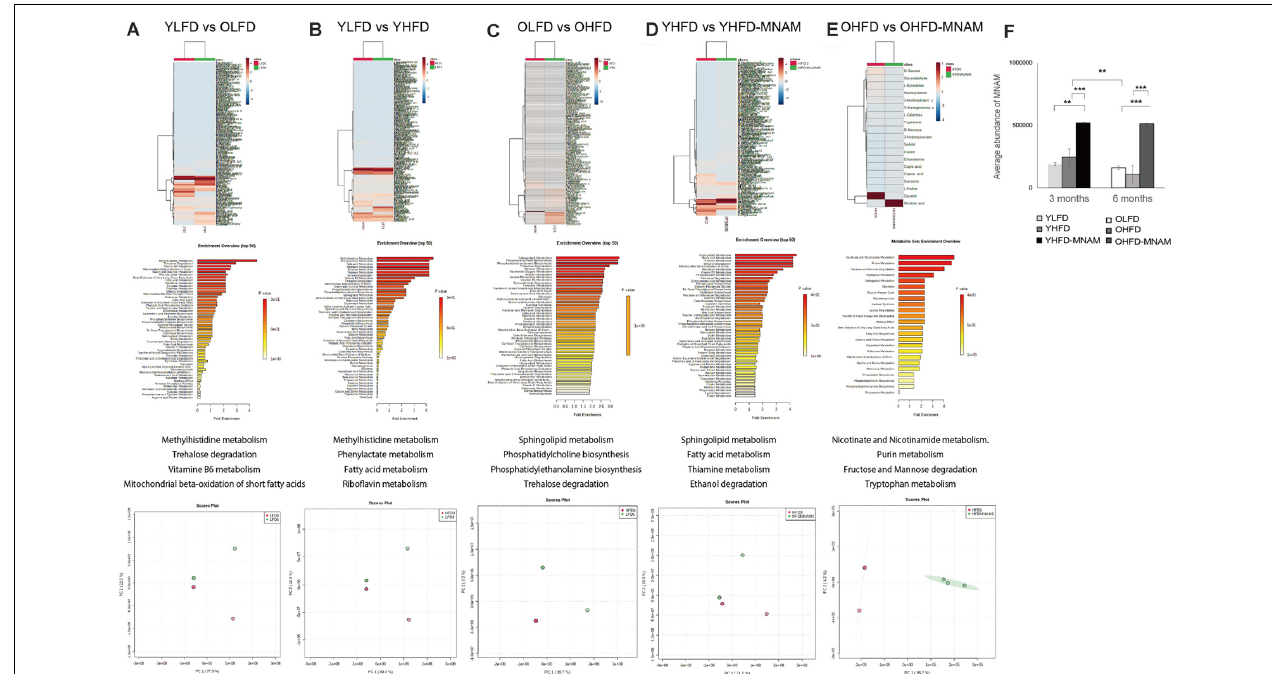
FIGURE 6 | Metabolome heatmap, enrichment analysis, and principal component analysis (PCA). (A) Comparison between the cochlea of the YLFD and OLFD mice. The metabolic pathways related to methylhistidine metabolism, trehalose degradation, vitamin B6 metabolism, and the mitochondrial beta-oxidation of short-chain saturated fatty acids were activated in the cochlea of the OLFD mice. (B) Comparison between the cochlea of the YLFD and YHFD mice. The metabolic pathways related to glycolysis and aging were activated in the cochlea of the YHFD mice. (C) Comparison between the cochlea of the OLFD and OHFD mice. The metabolic pathways related to insulin resistance, obesity, non-alcoholic steatohepatitis, and aging showed greater activation in the cochlea of the OHFD mice. (D) Comparison between the cochlea of the YHFD and YHFD-MNAM mice. The metabolic pathways related to sphingolipid metabolism, fatty acid metabolism, thiamine metabolism, ethanol degradation, the mitochondrial beta-oxidation of short-chain saturated fatty acids, and riboflavin metabolism showed greater activation in the cochlea of the YHFD-MNAM mice. (E) Comparison between the cochlea of the OHFD and OHFD-MNAM mice. The metabolic pathways related to nicotine and nicotinamide metabolism, purine metabolism, fructose, and mannose degradation and tryptophan metabolism showed greater activation in the cochlea of the OHFD-MNAM mice. (F) MNAM metabolomic analysis peaks in the cochlea at 3 and 6 months after the commencement of the experiment. MNAM expression in both YHFD and OHFD decreased with aging ( p = 0.002). MNAM expression in YHFD-MNAM increased compared to the expression in YLFD and YHFD ( p = 0.001 and p < 0.001, respectively). MNAM expression in OHFD-MNAM increased compared to the expression in OLFD and OHFD ( p < 0.001 and p < 0.001, respectively). YLFD, low-fat diet-fed 3-month-old mice; OLFD, low-fat diet-fed 6-month-old mice; YHFD, high-fat diet-fed 3-month-old mice; OHFD, high-fat diet-fed 6-month-old mice; YHFD-MNAM, high-fat diet plus 1% N 1 -methylnicotinamide-fed 3-month-old mice; OHFD-MNAM, a high-fat diet plus